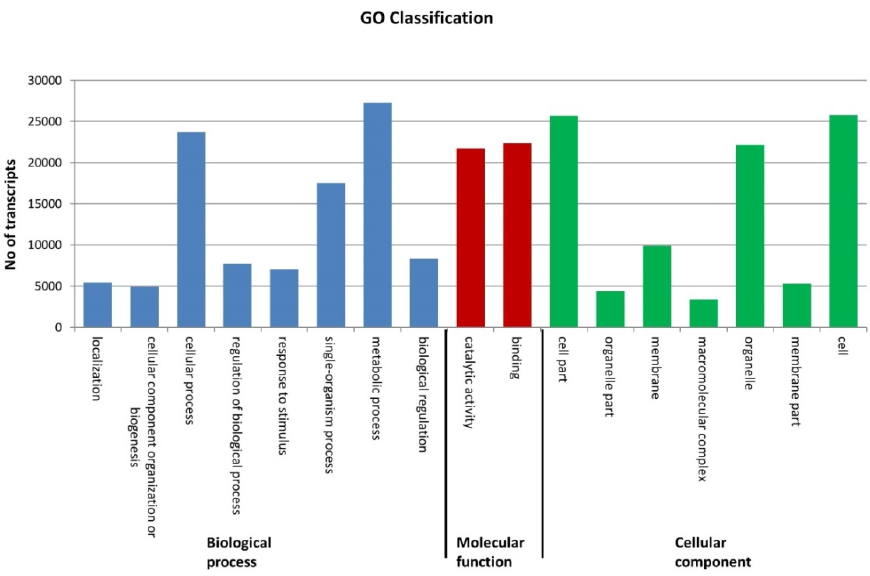
Figure 2. GO classification categories for phalaris unigenes.